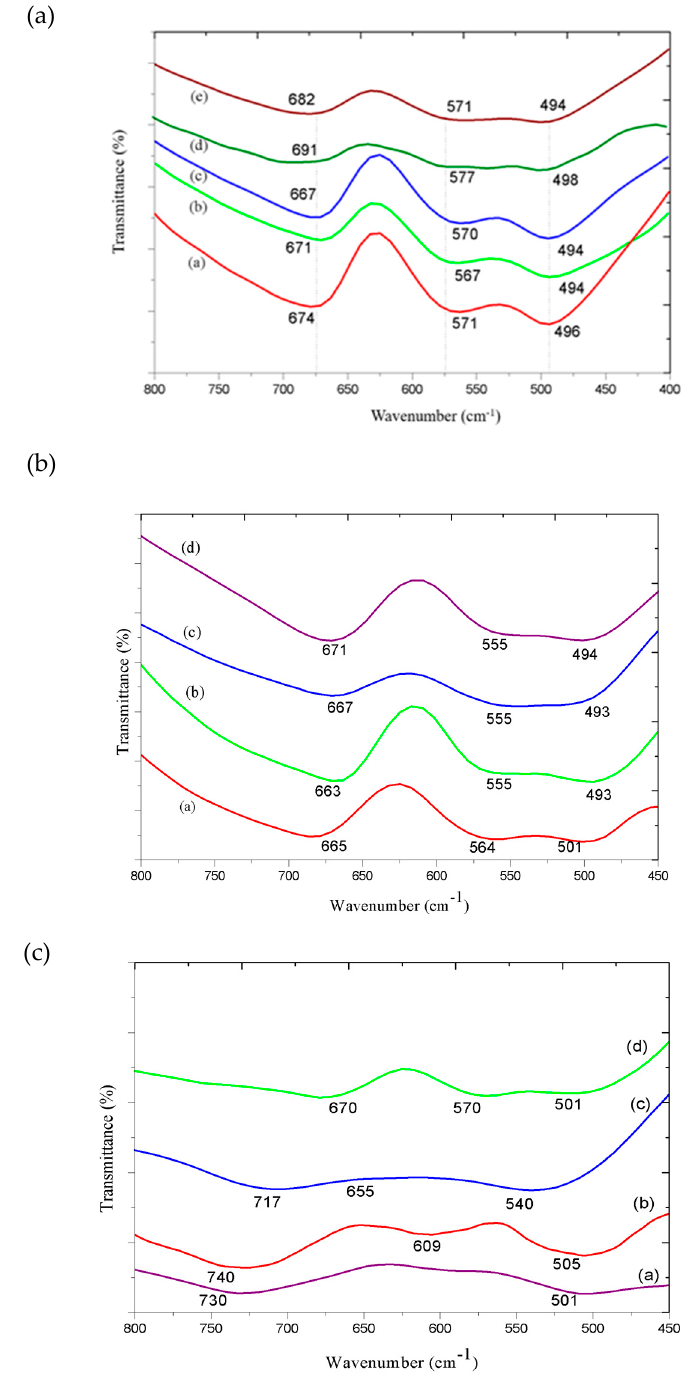
Figure 2. Infrared with Fourier transform of the samples obtained uisng the metal-chitosan Figure2. InfraredwithFouriertransformofthesamplesobtaineduisngthemetal-chitosancomplexation complexation method: ( a )—a) ZnAl 2 O 4 –550, b) ZnAl 2 O 4 –650, c) ZnAl 2 O 4 –750, d) ZnAl 2 O 4 –850, e) method: ( a )—(a) ZnAl 2 O 4 –550, (b) ZnAl 2 O 4 –650, (c) ZnAl 2 O 4 –750, (d) ZnAl 2 O 4 –850, (e) ZnAl 2 O 4 –950; ( b )—(a) CoAl 2 O 4 –750, (b) Co 0.9 Zn 0.1 Al 2 O 4 –750, (c) Co 0.5 Zn 0.5 Al 2 O 4 –750, (d) Co 0.1 Zn 0.9 Al 2 O 4 –750; ZnAl 2 O 4 –950; ( b )—a) CoAl 2 O 4 –750, b) Co 0.9 Zn 0.1 Al 2 O 4 –750, c) Co 0.5 Zn 0.5 Al 2 O 4 –750, d) Co 0.1 Zn 0.9 Al 2 O 4 – ( c )—(a) NiAl 2 O 4 –950, (b) Ni 0.9 Zn 0.1 Al 2 O 4 –950, (c) Ni 0.5 Zn 0.5 Al 2 O 4 –950, (d) Ni 0.1 Zn 0.9 Al 2 O 4 750; ( c )—a) NiAl 2 O 4 –950, b) Ni 0.9 Zn 0.1 Al 2 O 4 –950, c) Ni 0.5 Zn 0.5 Al 2 O 4 –950, d) Ni 0.1 Zn 0.9 Al 2 O 4 –950.